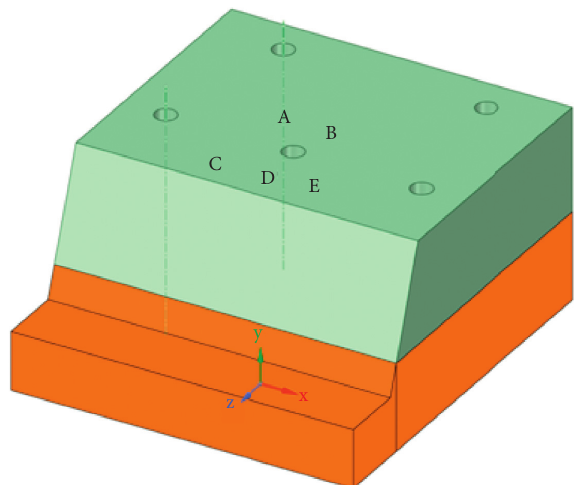
Figure 3: Special point Table 2: The model group with different hole network parameters.